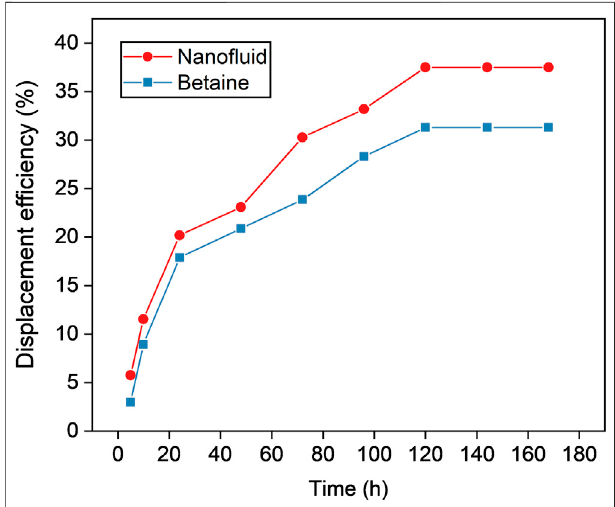
FIGURE10| Displacementef fi ciencyofdifferentoildisplacementagents (0.1 mD).